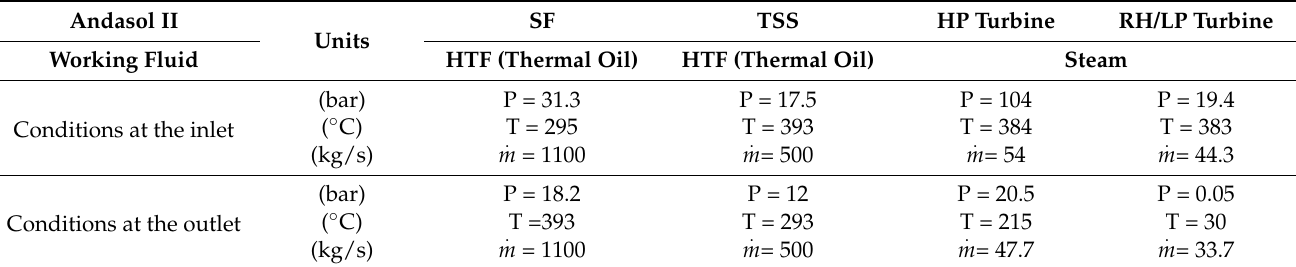
Table 1. Technical data of the real power